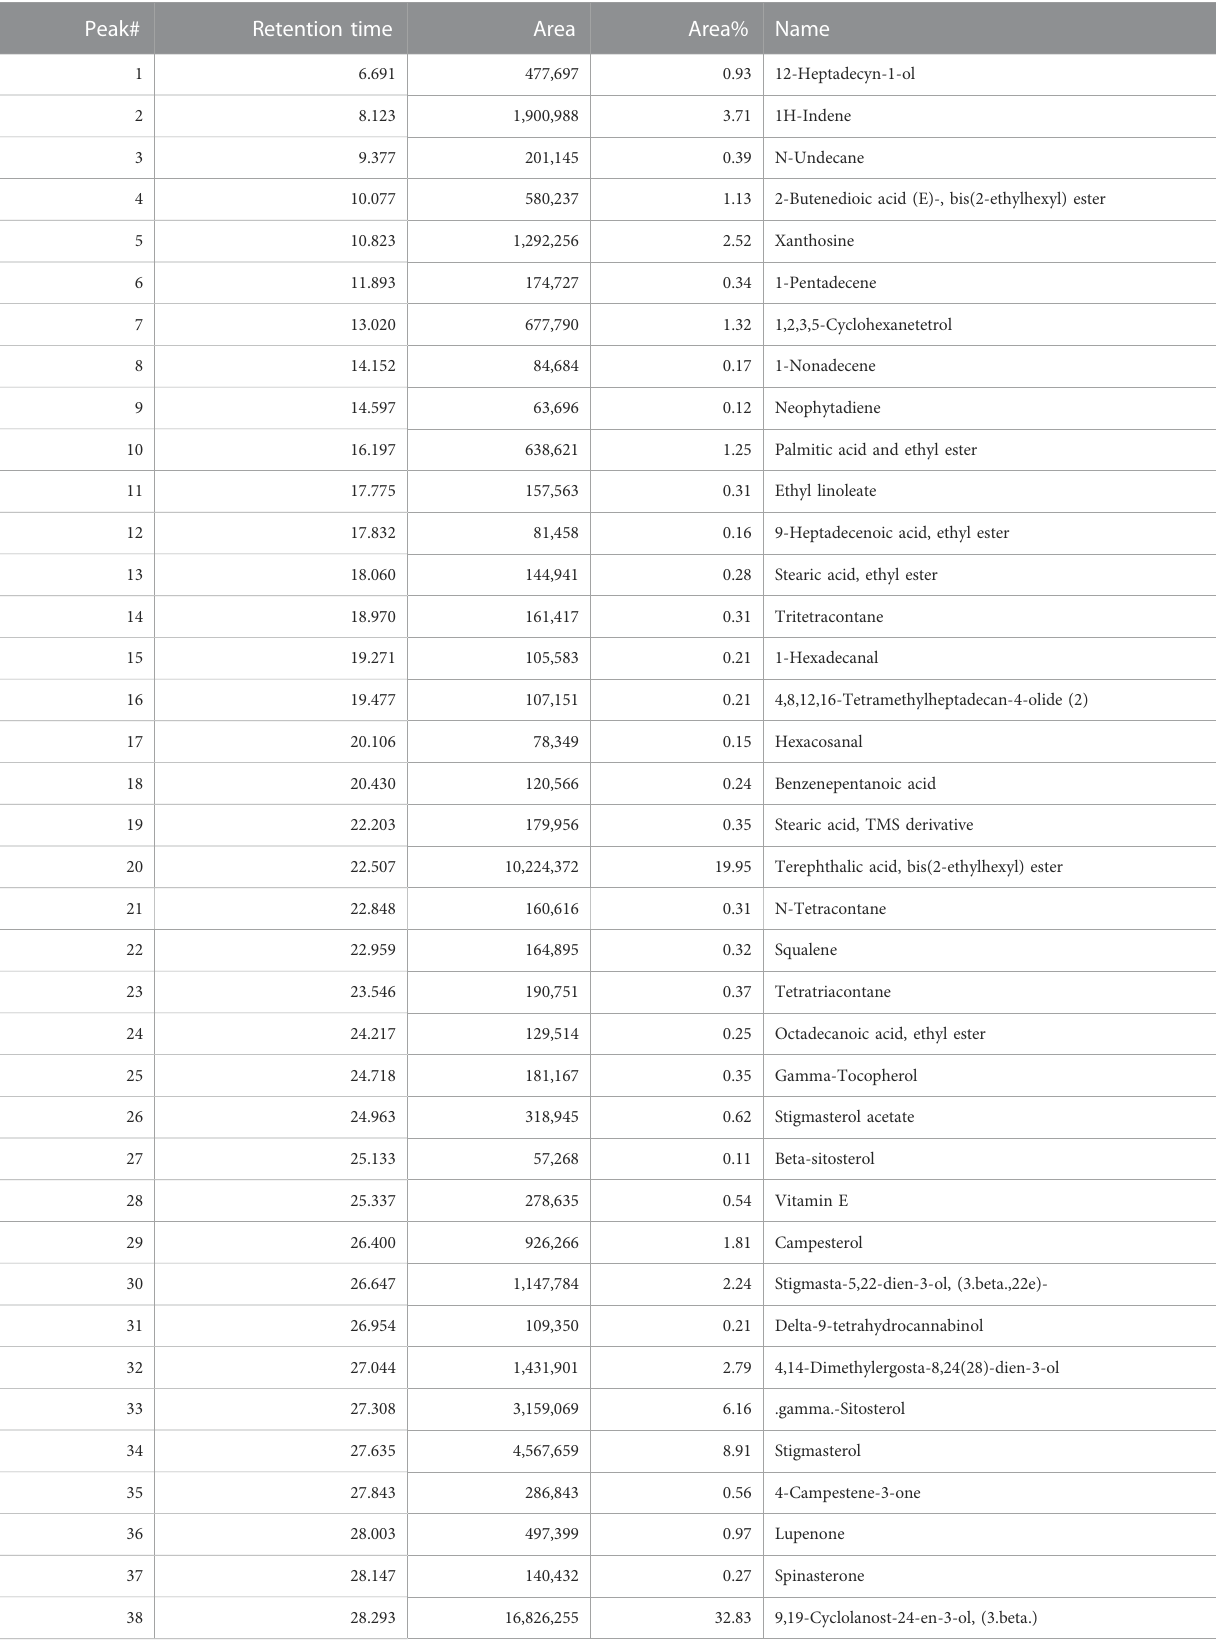
TABLE 1 Compounds identi fi ed by GC-MS analysis of an alcoholic root extract of Ipomoea turpethum .